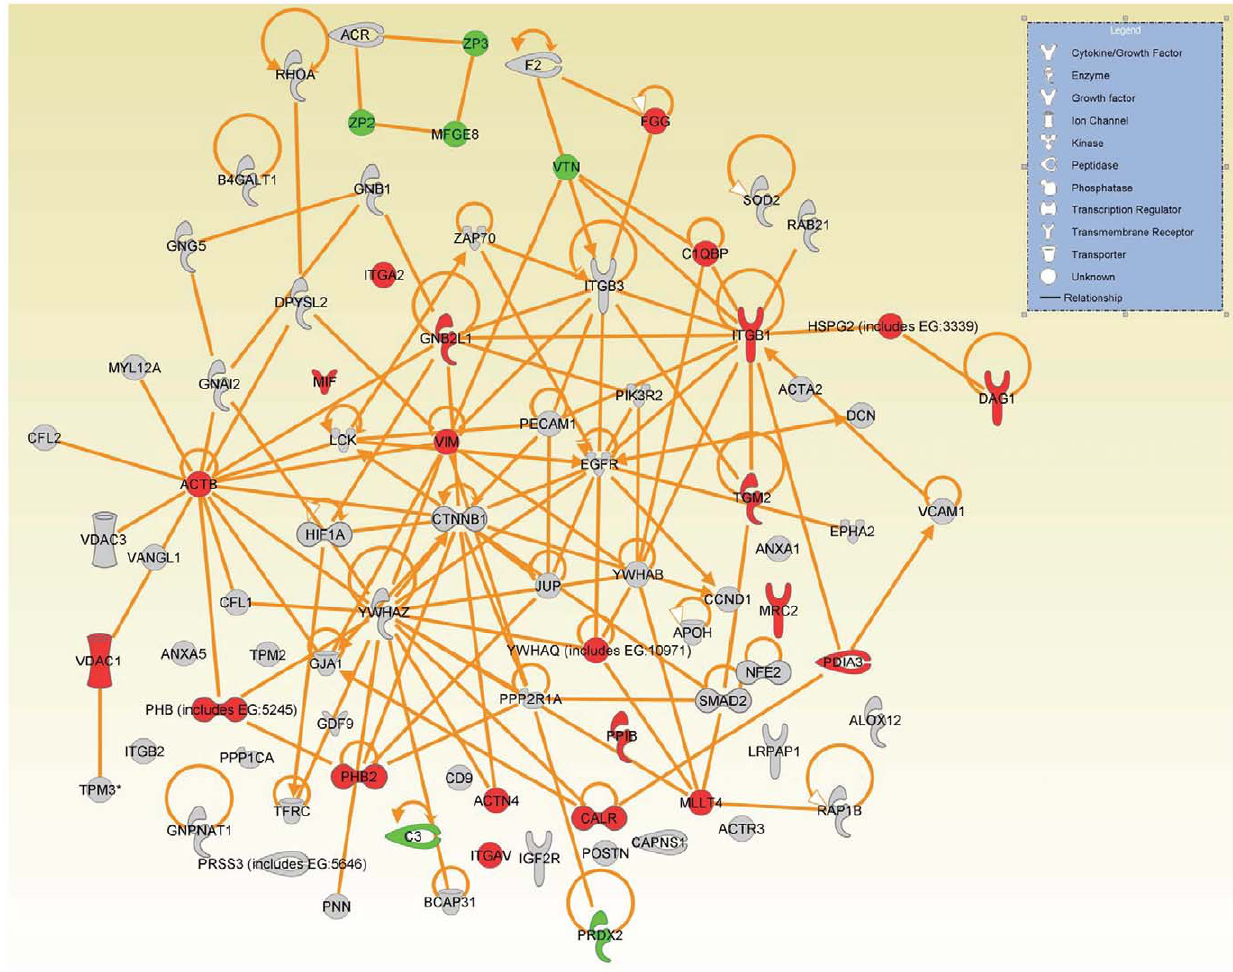
Figure 6. Cell-to-cell signaling and interaction network. Network generated with proteins involved in cell-to-cell signaling biological process using Ingenuity Pathway Analysis (IPA) as described in materials and methods. Each node represents a protein; proteins in shaded nodes were found in either GV oocyte or cumulus cell or both (see Table 3). Proteins in red and green nodes were higher and lower, respectively, in cumulus cells compared with GV oocytes.